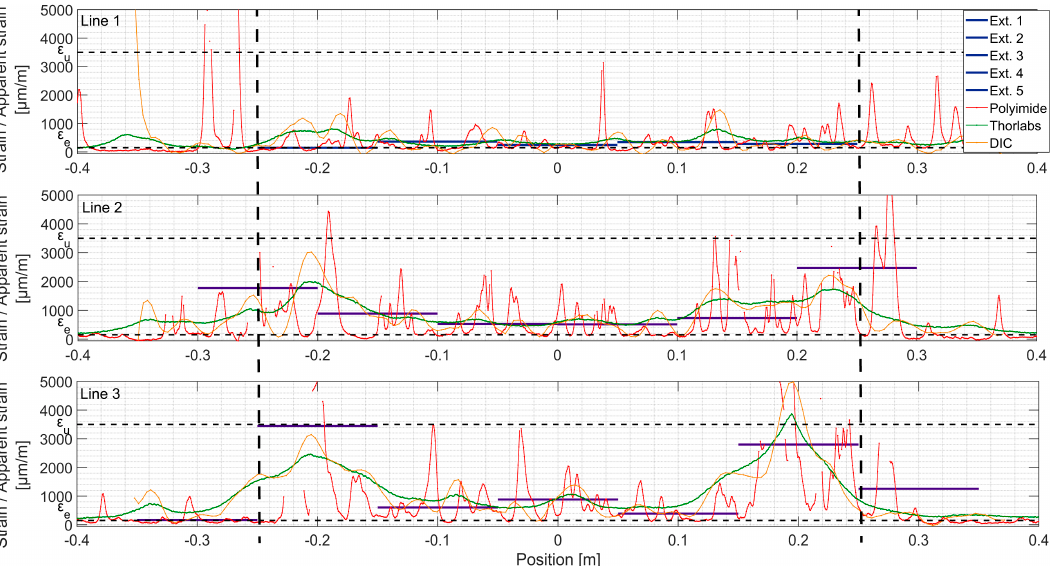
Figure 13. Strains measured with different techniques, load step 4, F = 150 kN; the constant bending moment zone is marked with dashed lines.